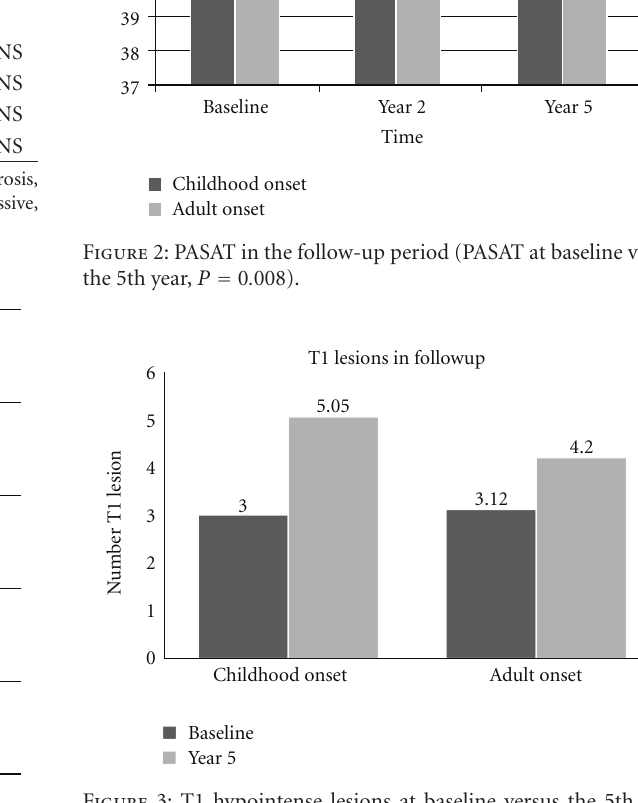
Figure 3: T1 hypointense lesions at baseline versus the 5th year, ( P = 0 .